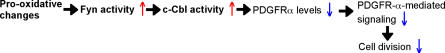
Diagrammatic Summary of the Fyn/c-Cbl Hypothesis of Toxicant ConvergenceThe results of our studies demonstrate a regulatory network in which oxidation causes activation of Fyn. Fyn then phosphorylates c-Cbl. Activation of c-Cbl leads to ubiquitylation of agonist-activated RTKs that are c-Cbl targets, with PDGFRα used here as an example of such a receptor. Reductions in levels of receptor lead to reduced activation of downstream signaling cascades.